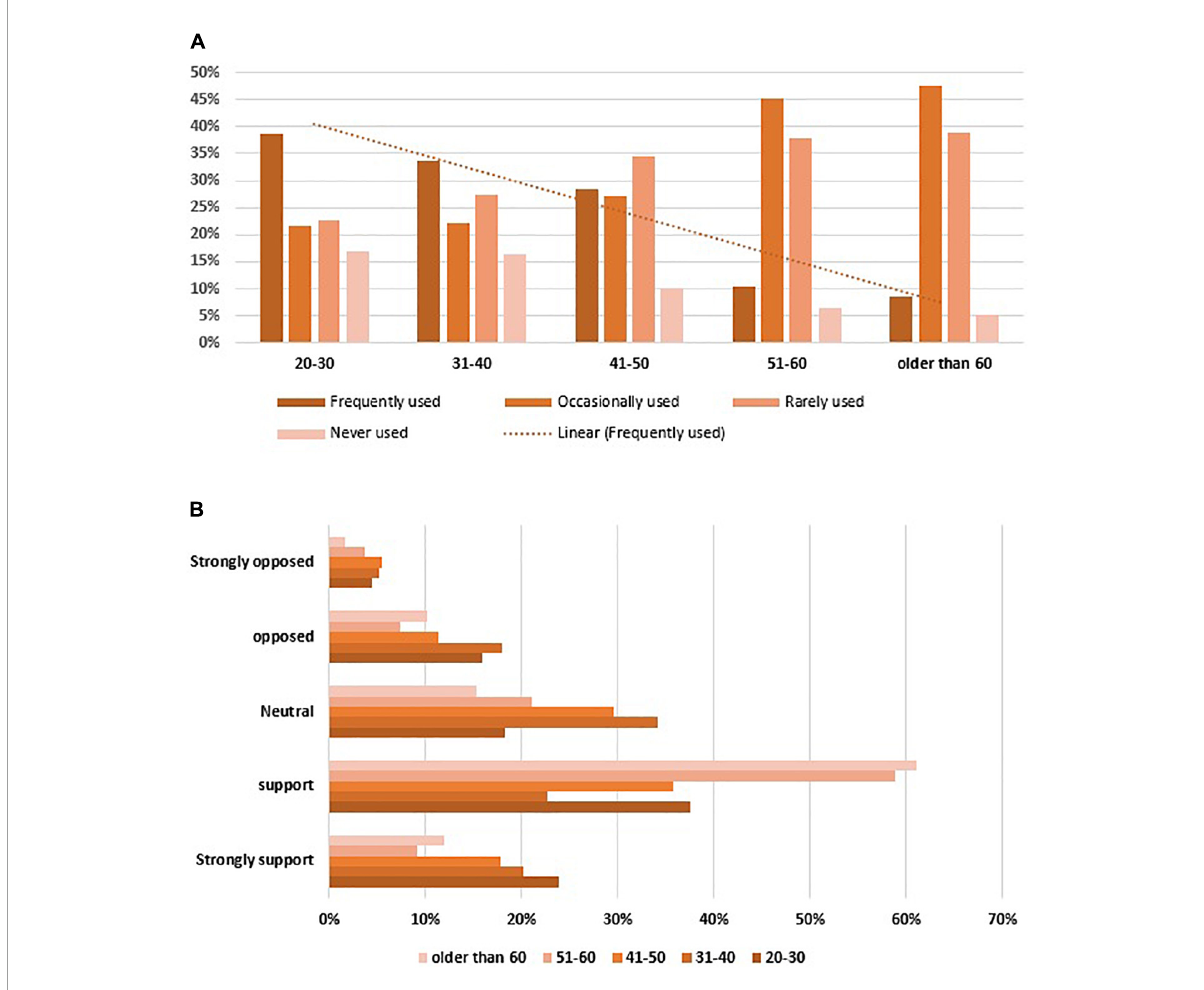
FIGURE1 Use of online teaching before COVID-19 stratified by age (A) and the willingness of moving teaching online stratified by age (B)